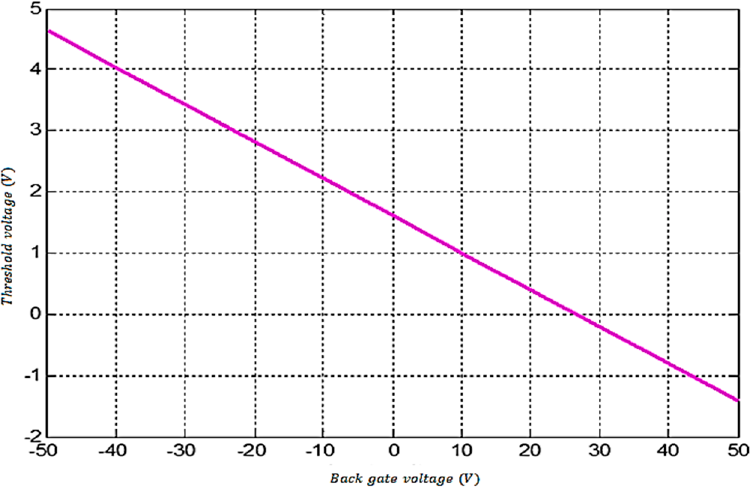
Table 1. Model parameters for bilayer graphene field effect transistor (FET).